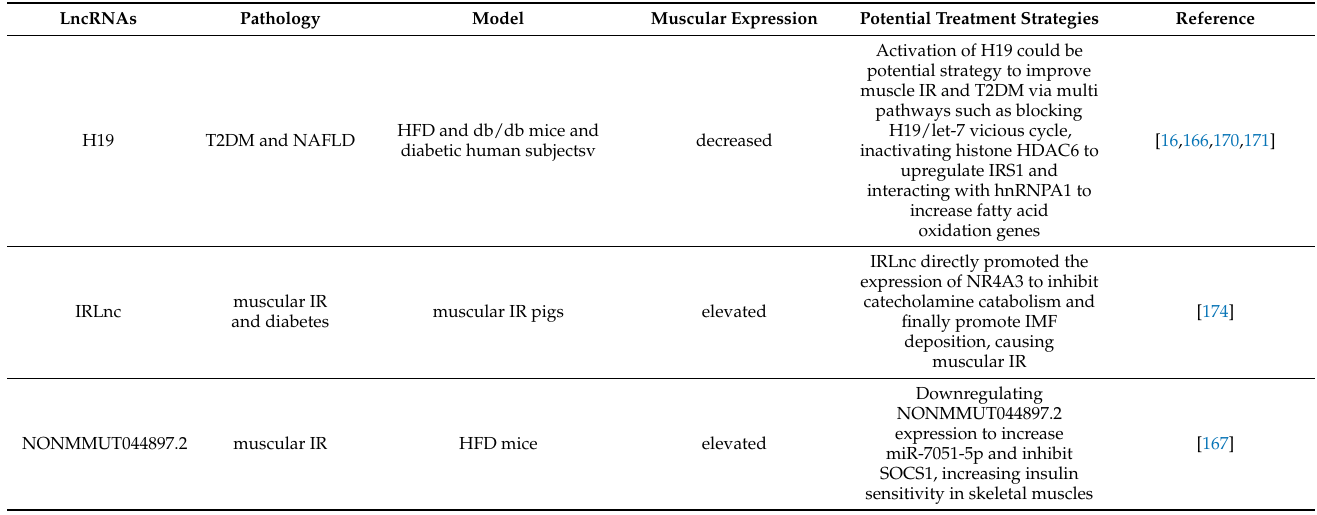
Table 2. LncRNAs in muscular IR and related